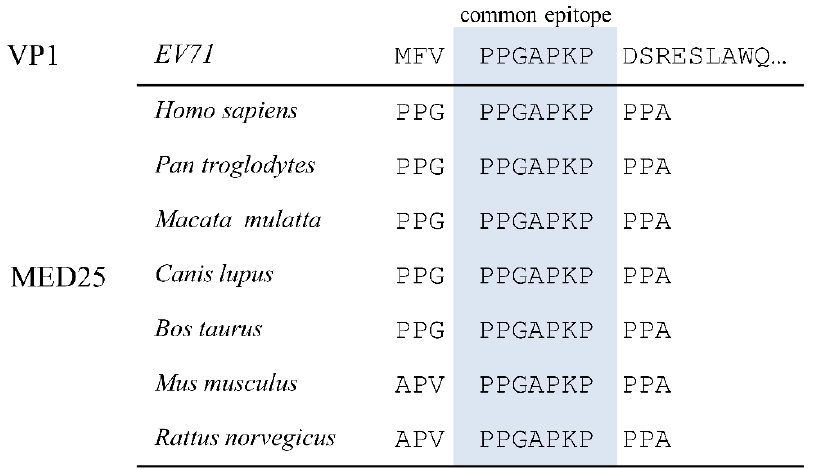
Figure 1. Alignment of amino acid sequences of common epitope in enterovirus 71 (EV71) virus protein 1 (VP1) with mediator complex subunit 25 (MED25) of various species. Shown are the common epitope sequence (highlighted) and flanking amino